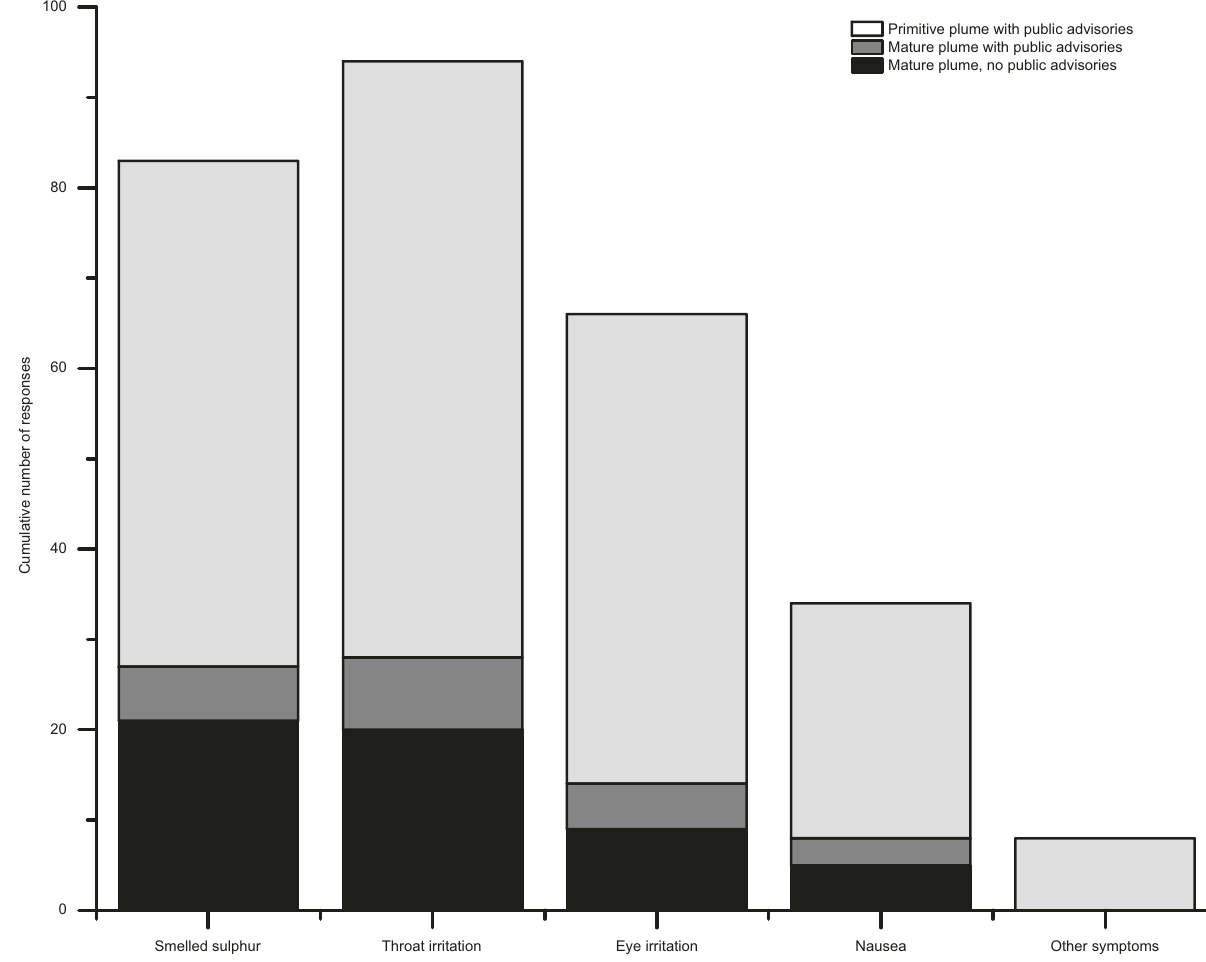
Fig. 5 Self-reported symptoms in Reykjavík. The fi gure shows the cumulative number of responses to the IMO online questionnaire. The responses are separated into those recorded on days impacted by a primitive plume (always associated with a public advisory), by a mature plume associated with public advisories, and by a mature plume not associated with a public advisory. ‘ Other symptoms ’ were recorded in free-form text box and included, e.g., headaches and increased asthma